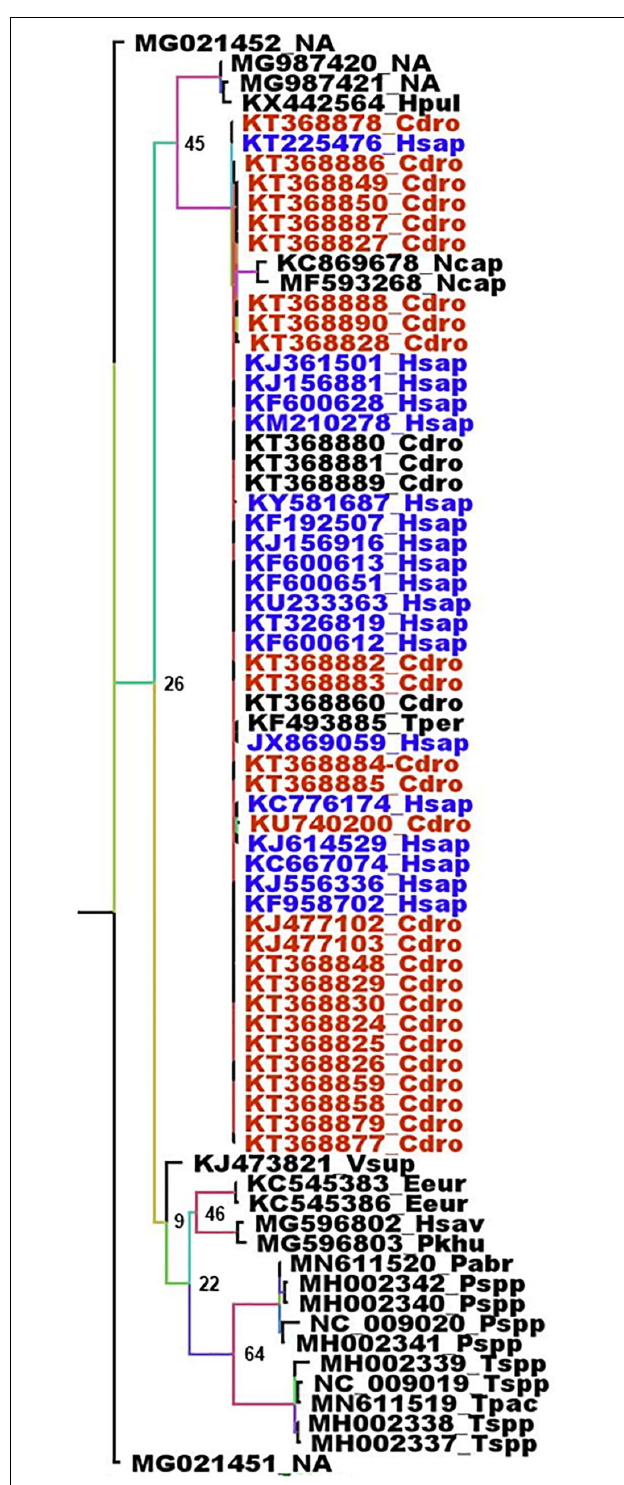
FIGURE 4 | Phylogenetic analysis of Merbecoviruses RdRp genes. The alignment of the full RdRp genes was performed with MUSCLE from the SeaView package (Gouy et al., 2010). The tree was built using the maximum likelihood method under the GTR model with 500 repeats. The tree